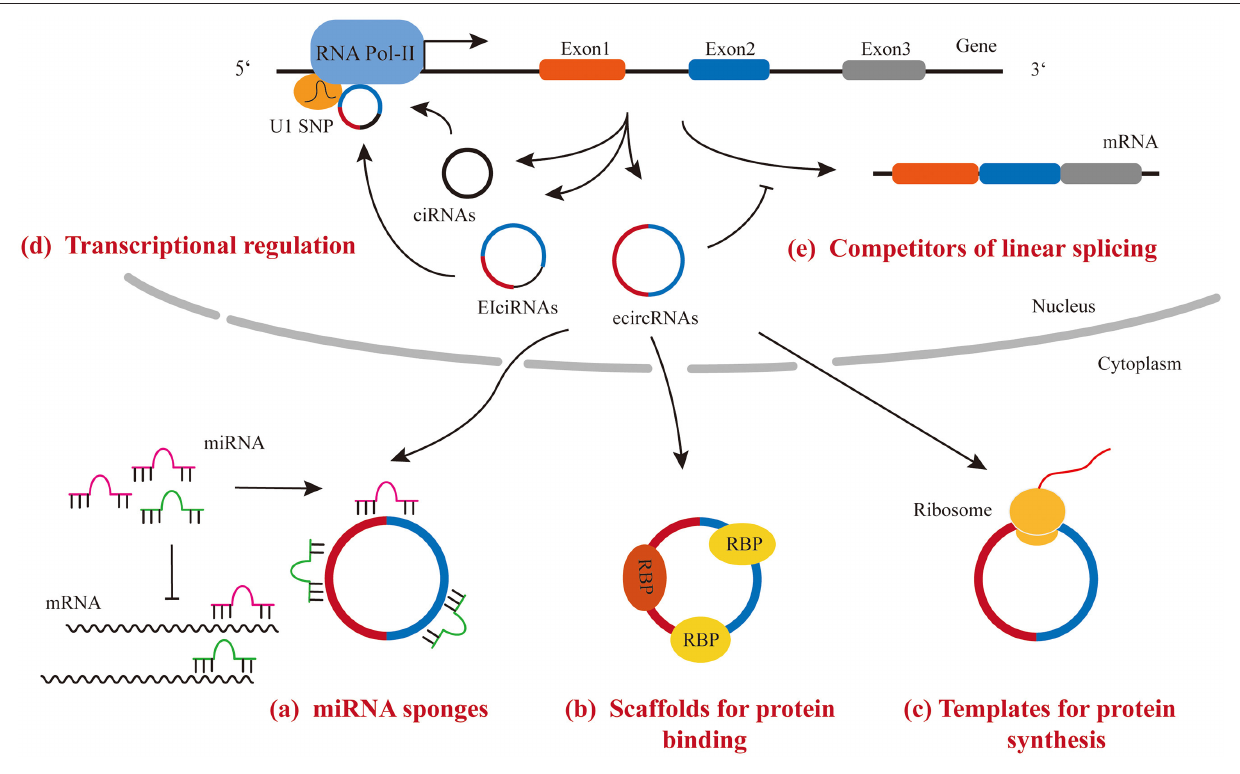
FIGURE 2 | Molecular mechanisms of regulatory function of